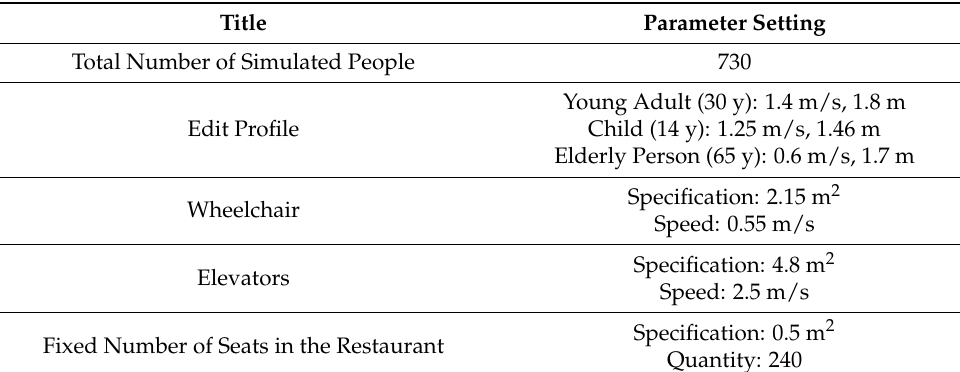
Table 4. Personnel parameter